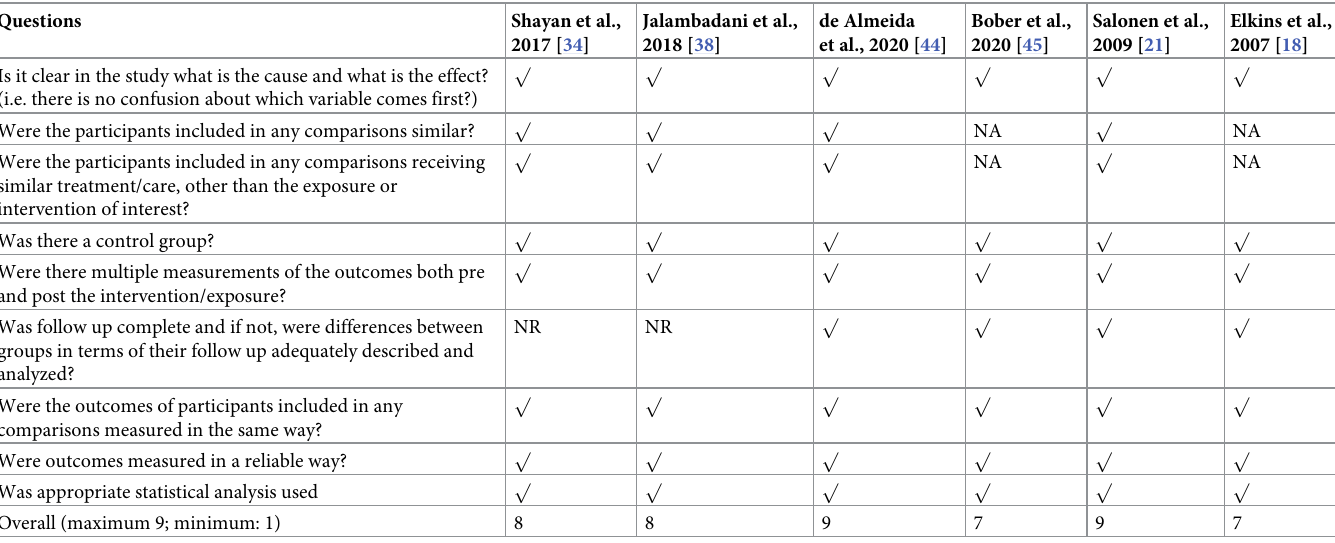
Table 2. Quality appraisal of quasi-experimental studies (N = 6). Questions